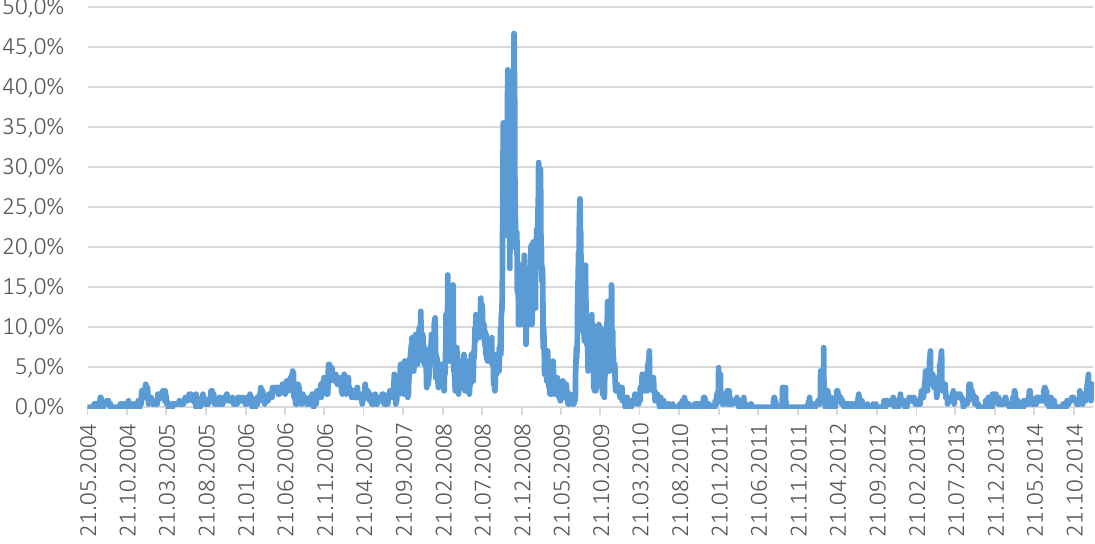
Note: Figure 8 depicts the percentage of individual stock returns, which rejected the equality hypothesis at each given date, measured as the number of stocks for which the hypothesis was rejected at every given sample, over the total number of stocks. The rolling sample size was set at 1,000 daily observations and the forecast sample at 100. The dates depict the end- date of each rolling sample. Figure 8. One-hundred (100) observation forecast sample using Wilcoxon rank-sum